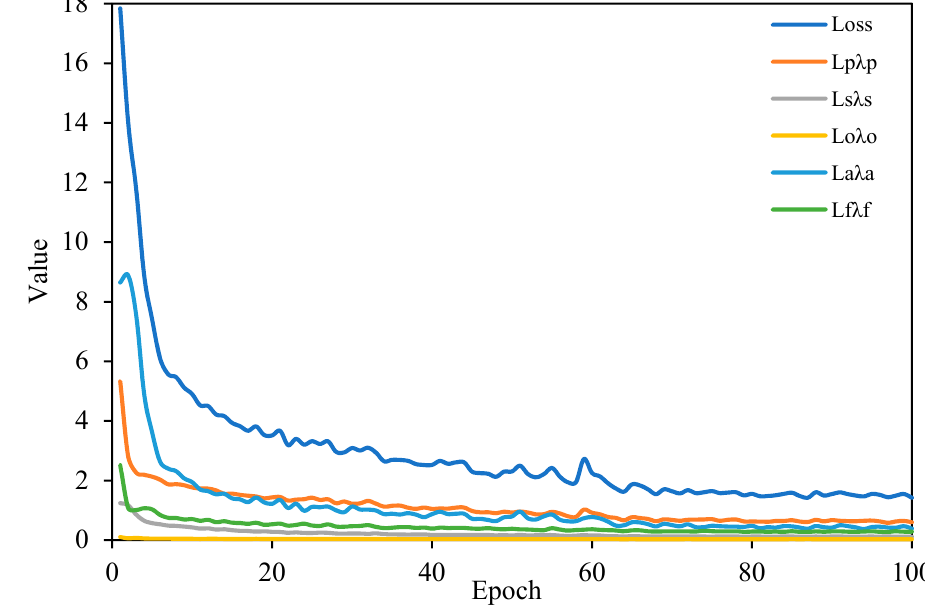
Figure 15. Variation of loss during training on the AIR-SARShip dataset.